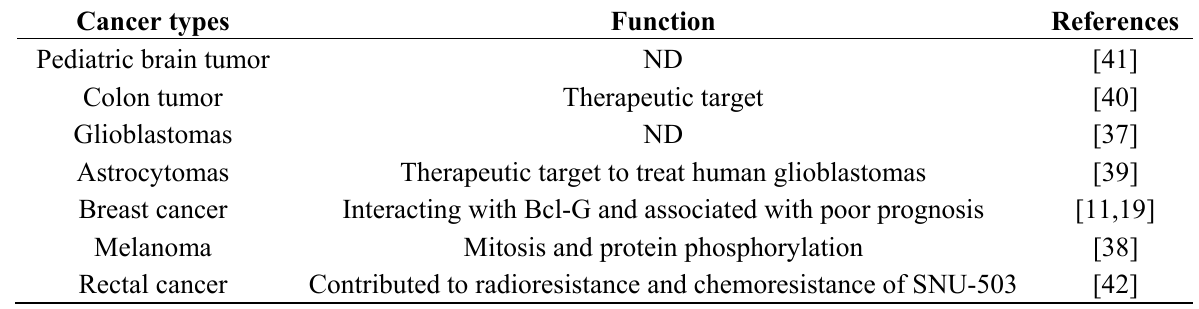
Table 1. Cancers in which maternal embryonic leucine zipper kinase (MELK) is overexpressed. Cancer types Function